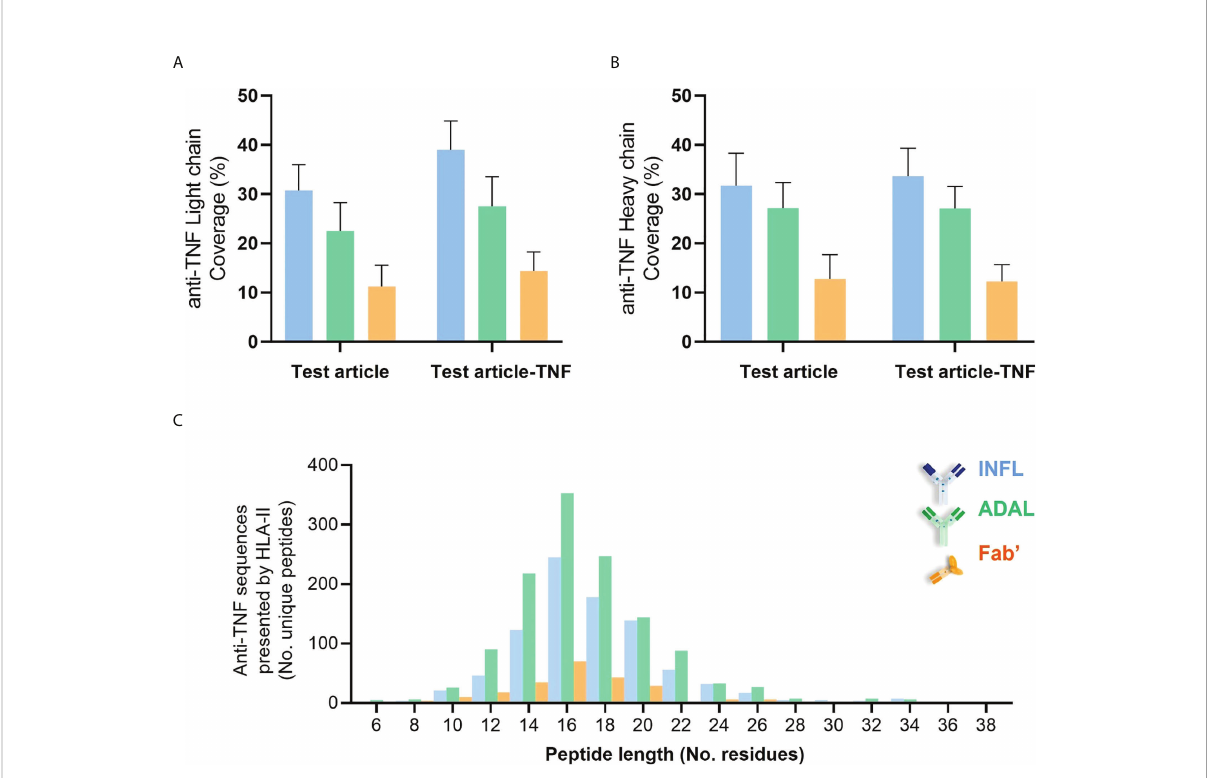
FIGURE 5 Length distribution of HLAII-associated peptides in monocytic DCs. (A) Length of total HLAII immunopeptidome in 126 data sets where each dot represents a detected peptide. (B) Frequency distribution of peptide length from a representative donor (D1237), where each bar corresponds to the number of peptides identi fi ed at a given residue-length. (C) HLAII peptide length distribution from different conditions was analyzed by frequency (D1237). Each bar corresponds to the number of peptides identi fi ed at a given residue-length in samples treated with INFL (blue), ADAL (green) and Fab ’ (orange) antibodies either alone ( light color ) or TNF-bound ( bold color